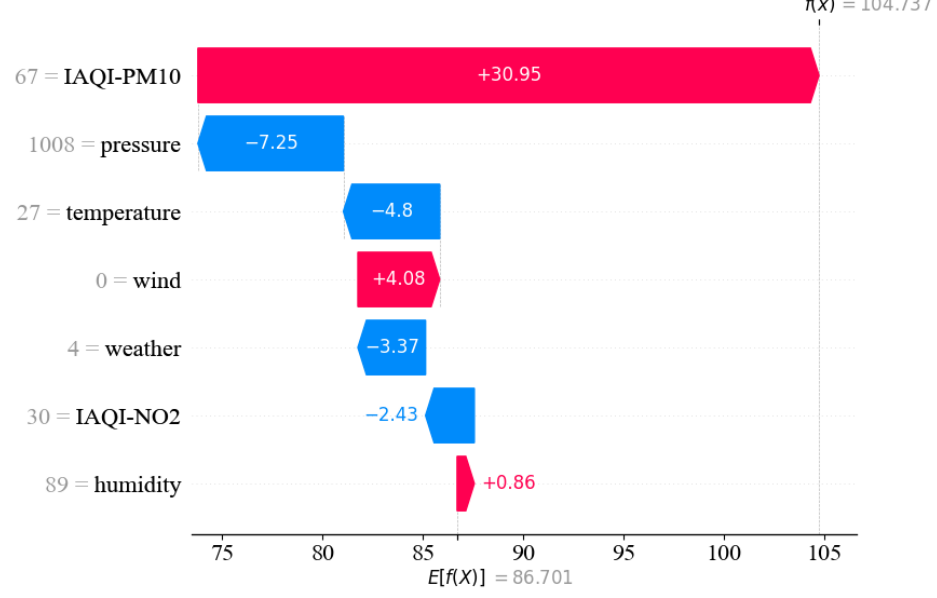
Figure 14. Influence of input features on IAQI-PM 2.5 prediction (local perspective).